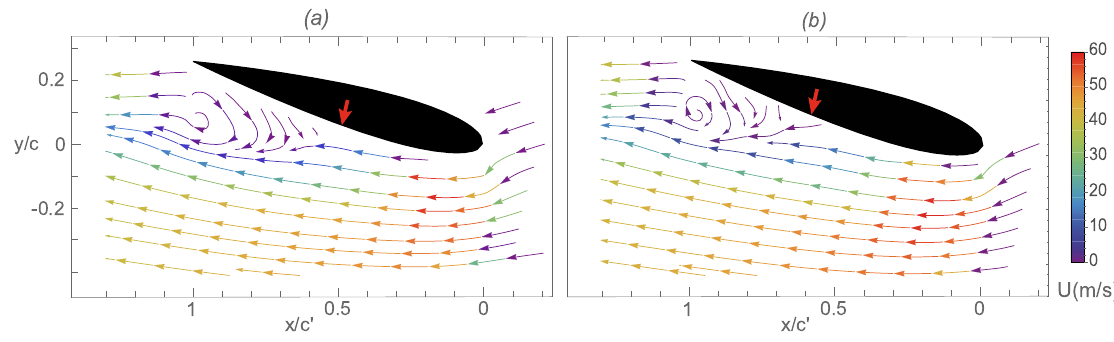
Figure 16. ( a ) Plasma-off and ( b ) plasma-on flow field at T B for α = 14.5 ◦ and U ∞ = 30